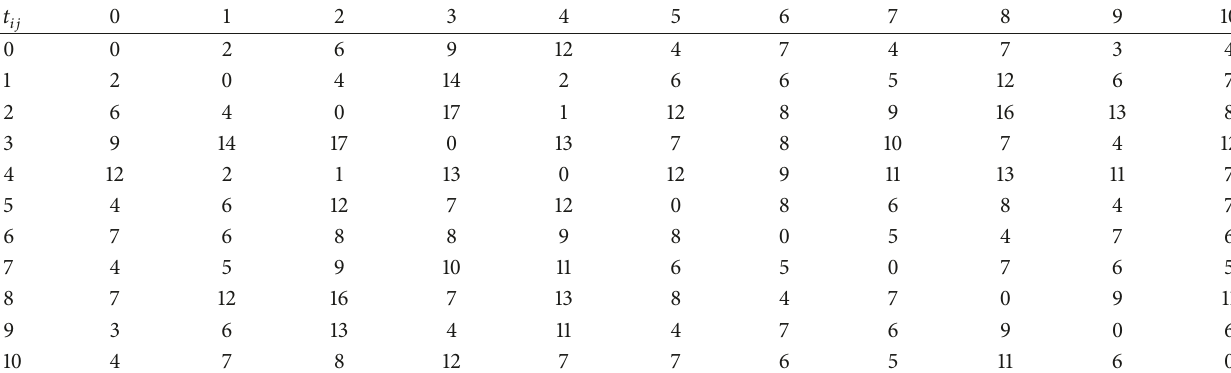
Table 4: 10-node travel time matrix for each point (unit: min).